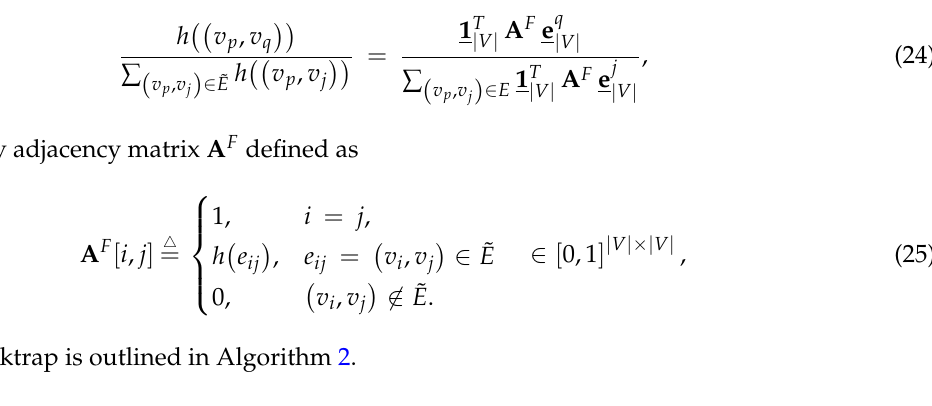
Algorithm 2: Fuzzy